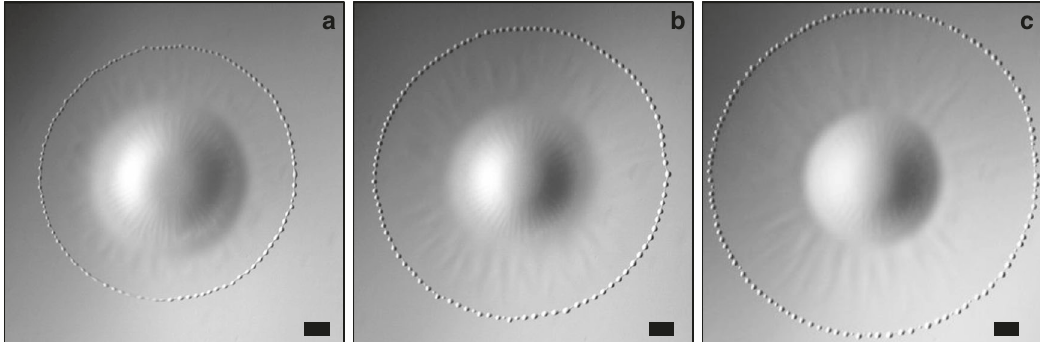
Fig. 3 Expanding stage of pulsation P 4 . a at time t ; b at time t + 28.3 ms; c at time t + 56.6 ms. Scale bar = 1 mm